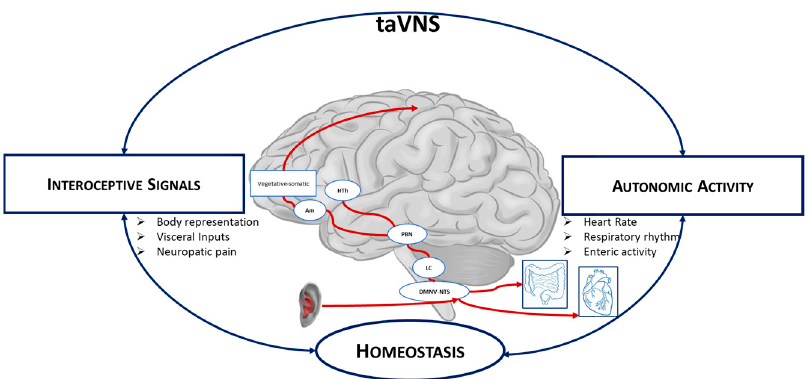
Figure 2. taVNS stimulation of the auricular branch of the vagus nerve (VN) projects to the nucleus tractus solitari (NTS), continuing to the locus coeruleus and parabrachial nucleus. From the parabrachial nucleus, it propagates to various subcortical and cortical brain regions. HTh: hypothalamus; PBN: parabrachial nucleus; LC: locus coeruleus; NTS: nucleus tractus solitary; DMNV: dorsal motor nucleus of the vagus nerve.